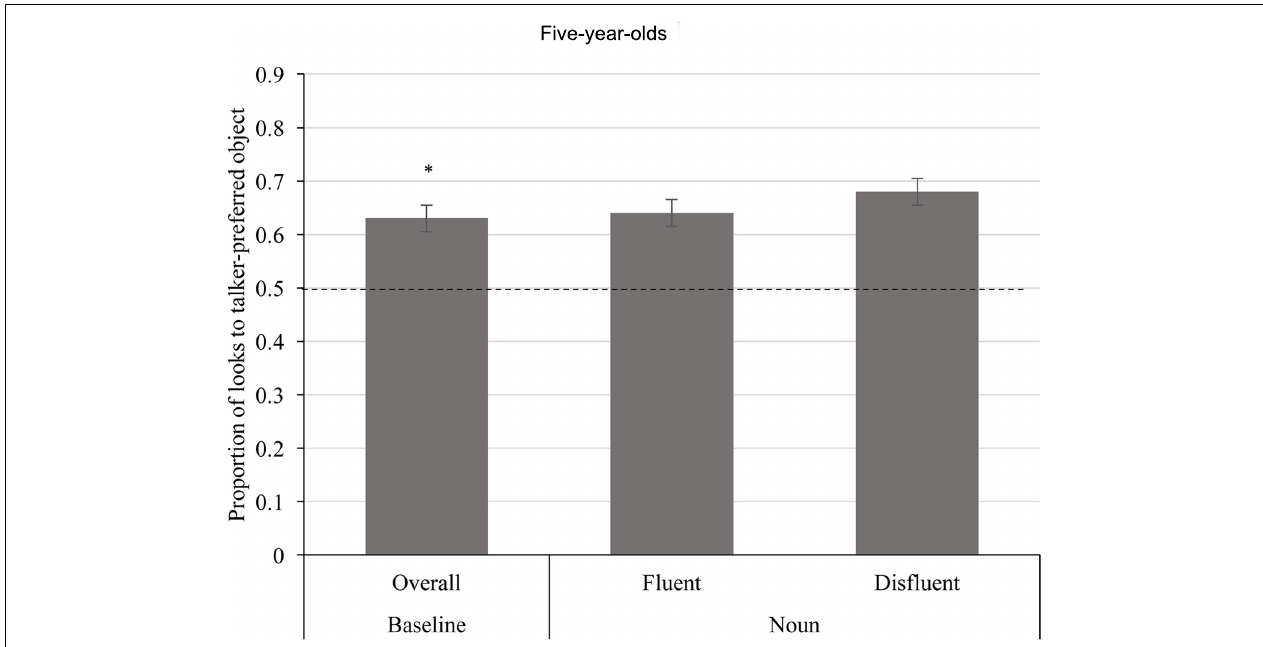
FIGURE 4 | Average proportion of time looking to talker-preferred objects during the baseline interval and noun interval for 5-year-old age group. The average proportion of time looking to the talker-preferred object was significantly greater than chance (0.50) during the baseline interval ( p < 0.001). There was no effect of fluency during the noun interval ( p = 0.180). Error bars depict standard errors. A single asterisk represents a significant difference from chance ( p <